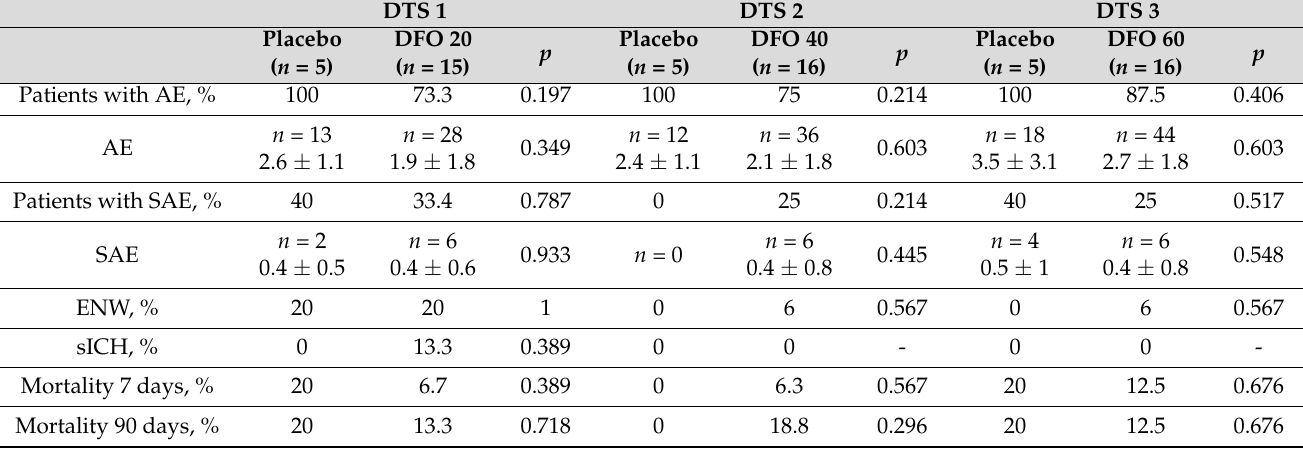
(Table 2), or hypodensity volume during the 36 h (Figure S1) post stroke-onset between placebo pool and DFO groups. Table 2. Safety and outcome results in the placebo and DFO group in each